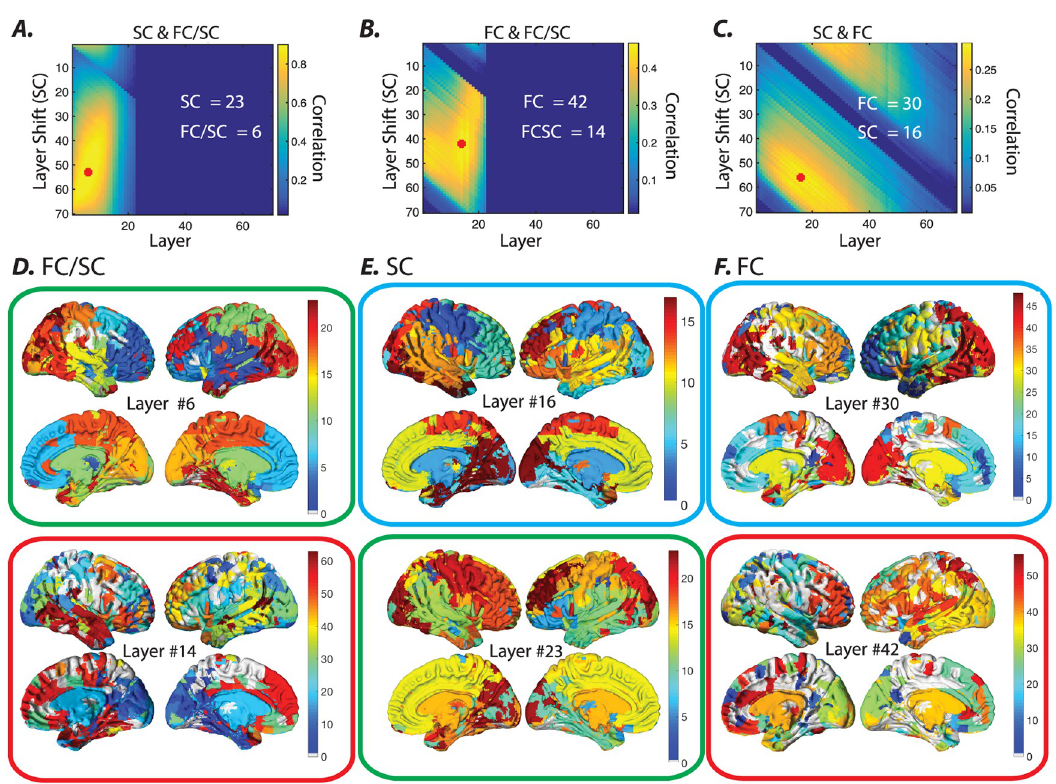
Fig 8. Similarity between the allegiance matrices of the multiplex SC-FC graph, the FC graph alone, and the SC graph alone, as a function of the topological scale for the group. Using a ( κ = 1), we calculated the Pearson correlation coefficient for all layers and all layer shifts between the allegiance matrices of (A) the multiplex SC-FC graph and the SC graph, (B) the multiplex SC-FC graph and the FC graph, and (C) the SC graph and the FC graph outside of the multiplex formulation. Layers and shifts with maximum correlation values are marked by � . The layer numbers that yield maximum correlation values are also presented on the plots (white). (D-F) Brain overlays show the communities identified at layers with maximal correlation values (panels (A-C) ). The color bars in each panel (right hand side) represent the color-coded communities. The multiplex SC-FC communities at low γ layers are very similar to SC communities at slightly higher γ layers (green boxes). Although FC communities overall show smaller similarity to the muliplex SC-FC communities, the multiplex SC-FC communities at higher γ layers show relatively higher similarity to FC communities at high γ layers (red boxes). The smallest similarity is observed between FC and SC graphs, peaking around a coarse scale with small γ values for both modalities (cyan boxes).